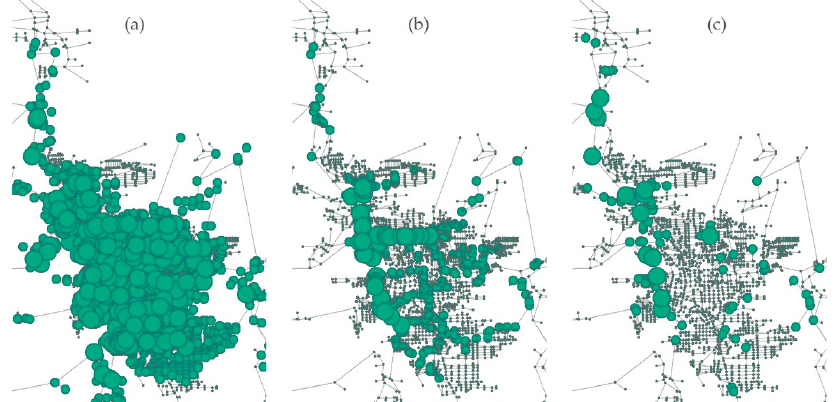
Figure 3. Spatial distribution of centralities for intersections (primal representation): ( a ) Closeness Centrality; ( b ) Betweenness Centrality; ( c ) Information Centrality. Source: Authors, July 2018.